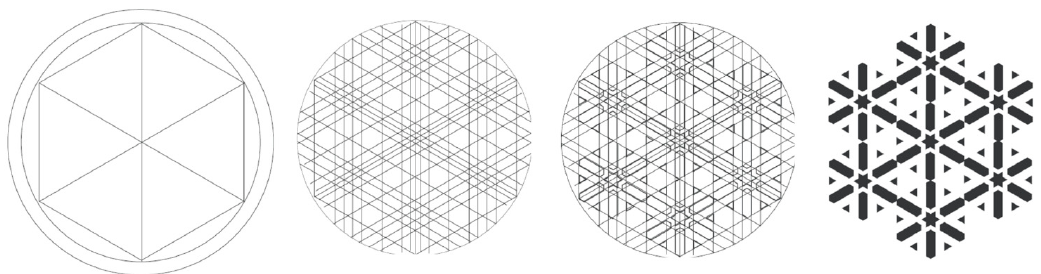
Figure 11. Closure.